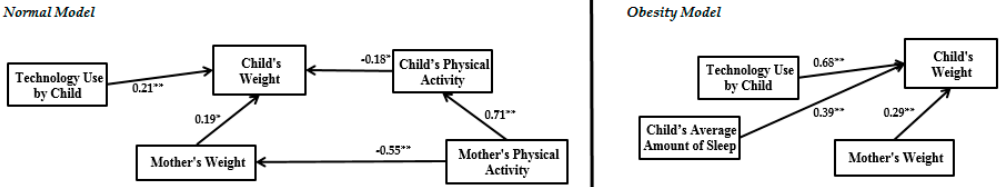
Figure 8. Structure of the impact of control variables on child’s weight in the obesity and normal models (* Significant in the level of 5%; ** Significant in the level of 1%).